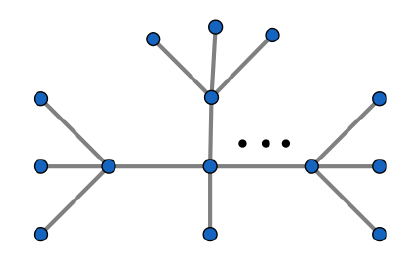
Figure 15 . The quadrangulation in this case is given by a chain of diagonals f i